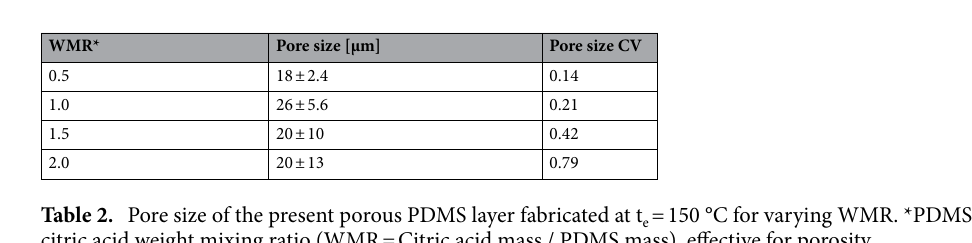
Table 2. Pore size of the present porous PDMS layer fabricated at t e = 150 °C for varying WMR. *PDMS and citric acid weight mixing ratio (WMR = Citric acid mass / PDMS mass), effective for porosity.